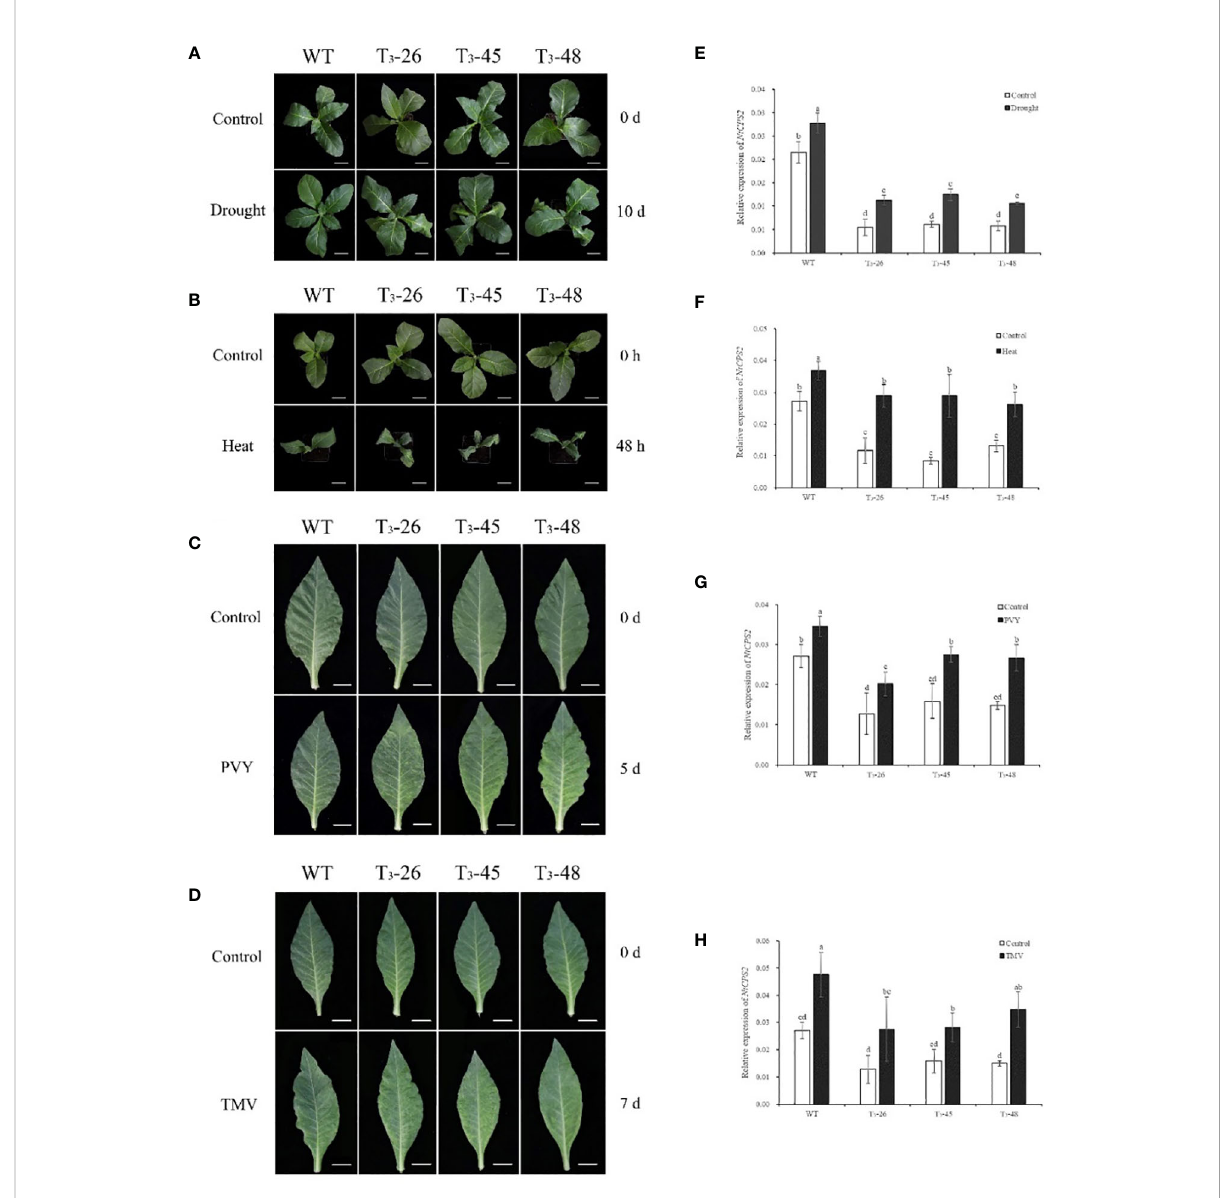
FIGURE 1 Transcript pro fi les of tobacco copalyl diphosphate synthase 2 ( NtCPS2 ) genes in response to abiotic stress or biological stress. Ten-week-old tobacco seedlings were treated with drought, 45°C heat, PVY or TMV, the photos were taken after 6 hours of drought stress, 48 hours of heat stress, 7 days of PVY inoculation or 7 days of TMV inoculation (A – D) . And seedlings were sampled after photography to extract RNA, and then transcript levels of NtCPS2 were checked by quantitative PCR (RT-qPCR) under drought stress (E) , heat stress (F) , PVY (G) or TMV (H) . In each quantitative reverse transcription quantitative PCR (RT-qPCR), the transcript levels of the tobacco reference gene L25 in different samples were also evaluated. Three technical replicates were performed for each experiment. The data shown are the mean ± SD of three independent experiments. Statistical analysis was performed using the ANOVA test (p< 0.05) and signi fi cant differences are indicated by different